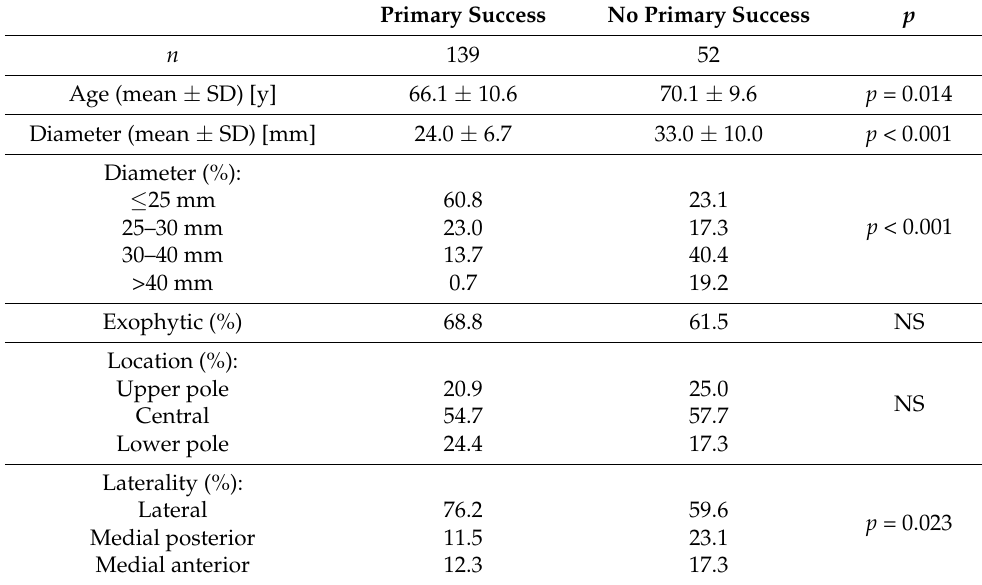
Table 2. Primary ablation success according to tumour size and location.